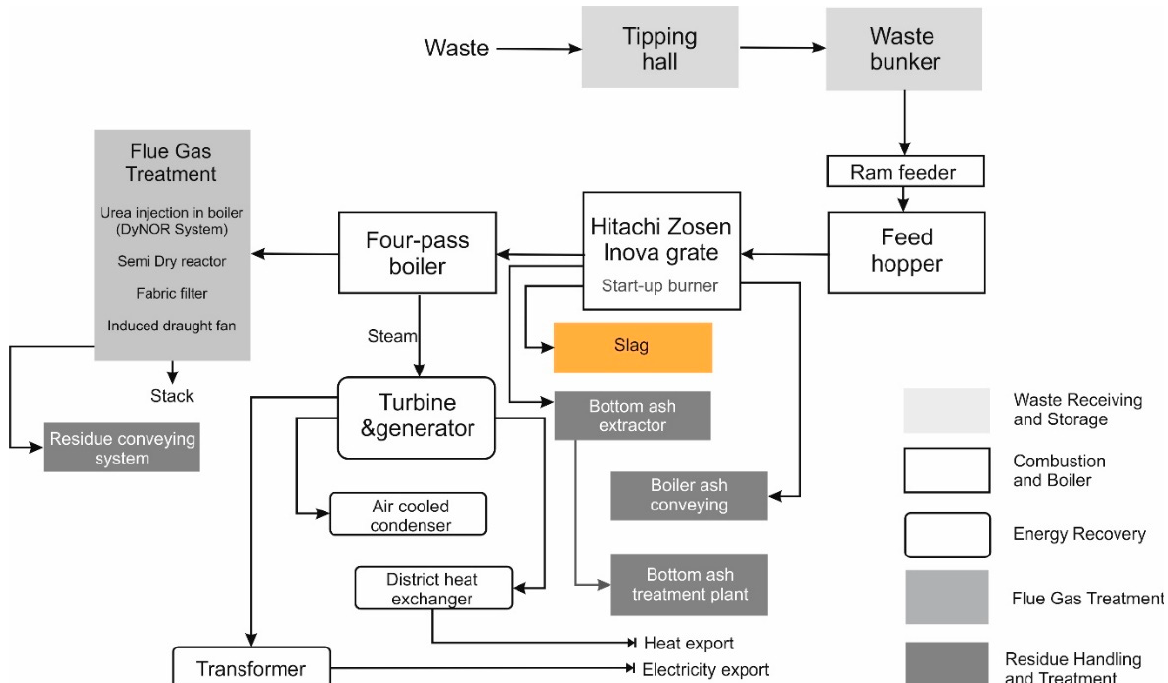
Figure 2. Simplified scheme of an analysed MSWI 2 incinerator.